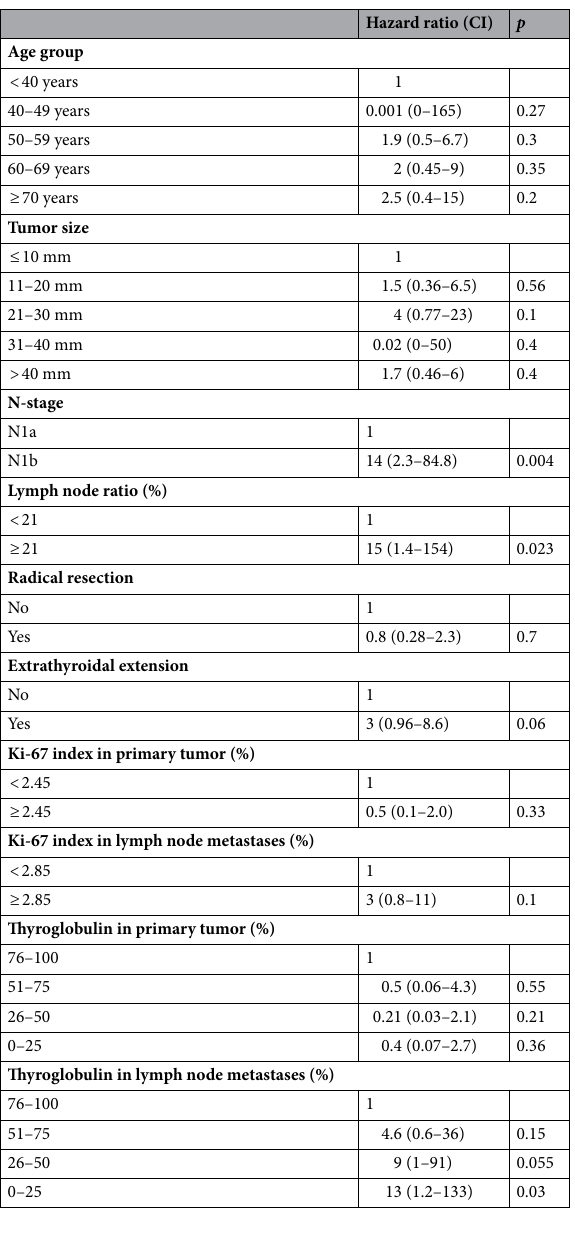
Table 4. Multivariate Cox proportional hazards model comparing tumor recurrence in relation to clinicopathological data in papillary thyroid cancer